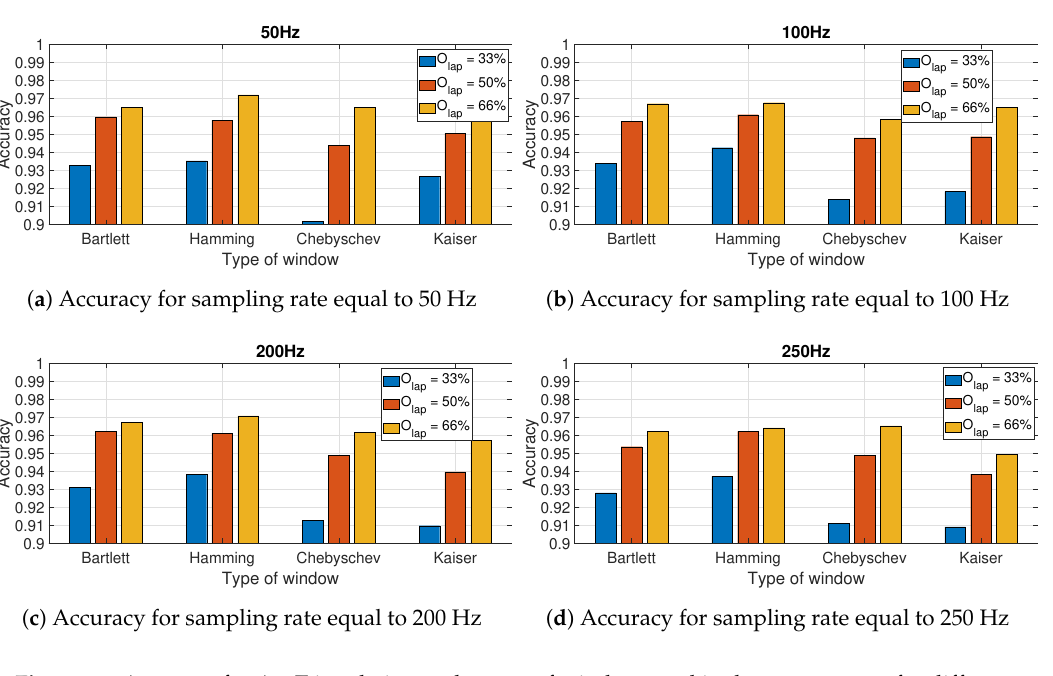
Figure 10. Accuracy for AccZ in relation to the size of window (based on the W R factor) used in the spectrogram for different sampling rates and different values of the overlapping factor O lap . The Hamming window is used to obtain these results.